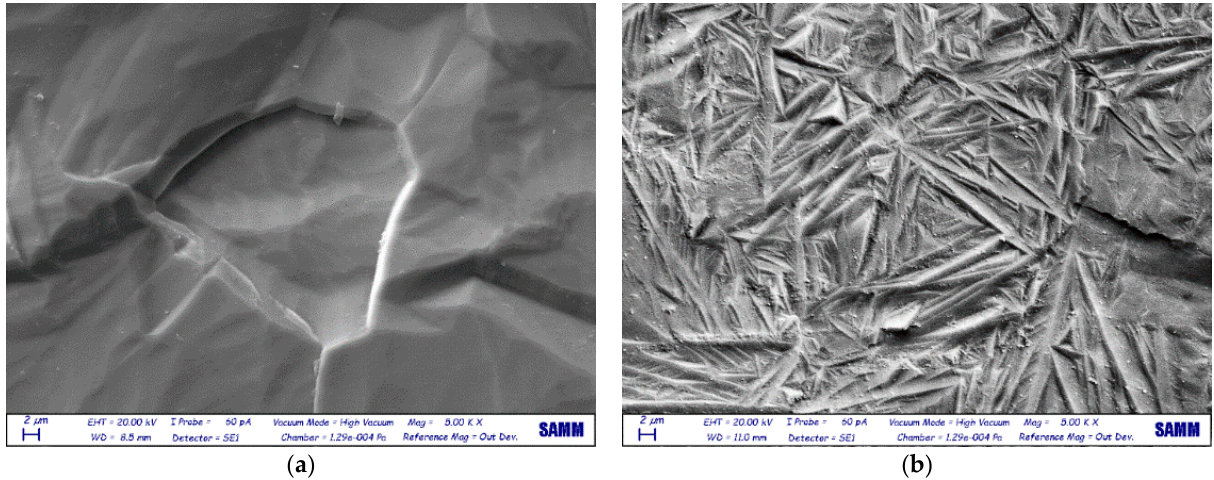
Figure 3. SEM images of ( a ) etched and ( b ) EB-treated Ti samples.